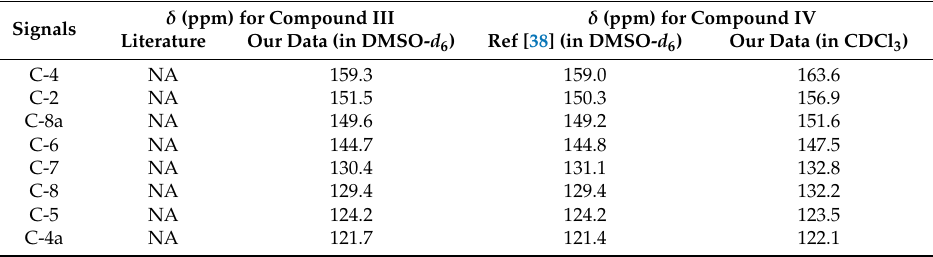
Table 2. Reported and our data for 13 C ‐ NMR spectroscopies of III and IV . δ (ppm) for Compound Signals